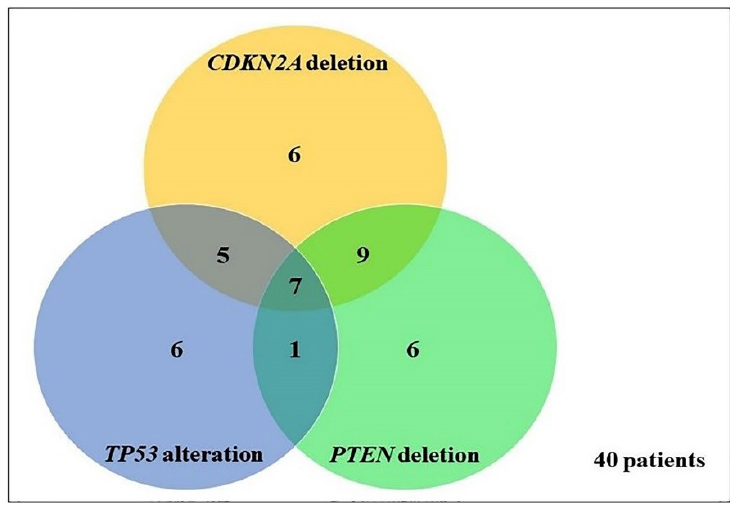
Figure 8. Association of TP53 , PTEN , and CDKN2A alteration in 40 gliomas.